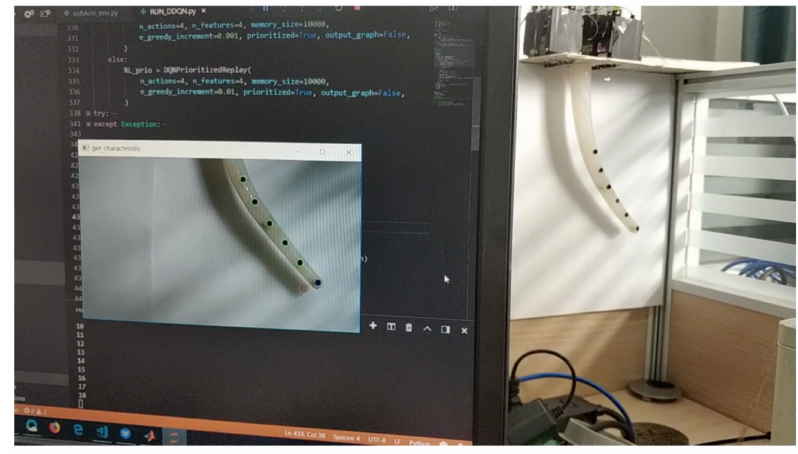
Figure 5. Experiment environment.